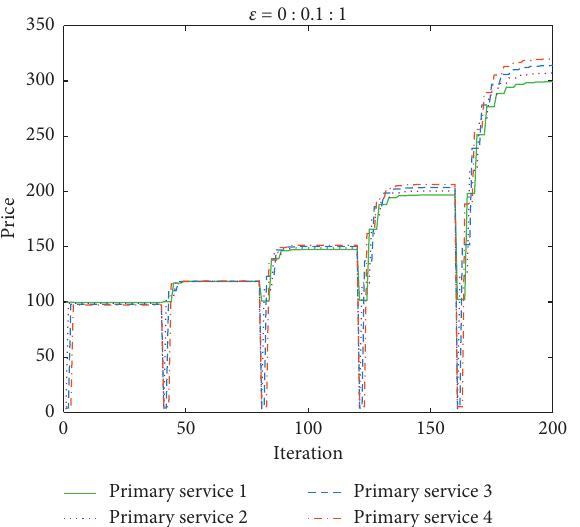
Figure 5: The relationship between price and iteration on interval ε � 0: 0.1 :1 for four